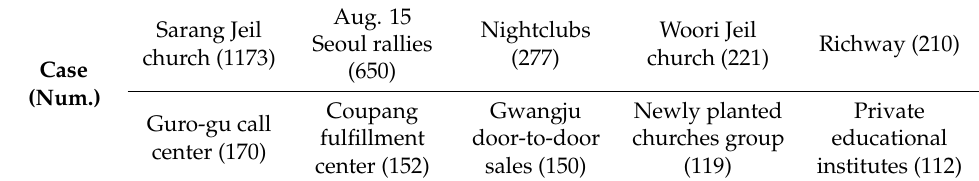
Table 3. Ten major COVID-19 cluster cases in